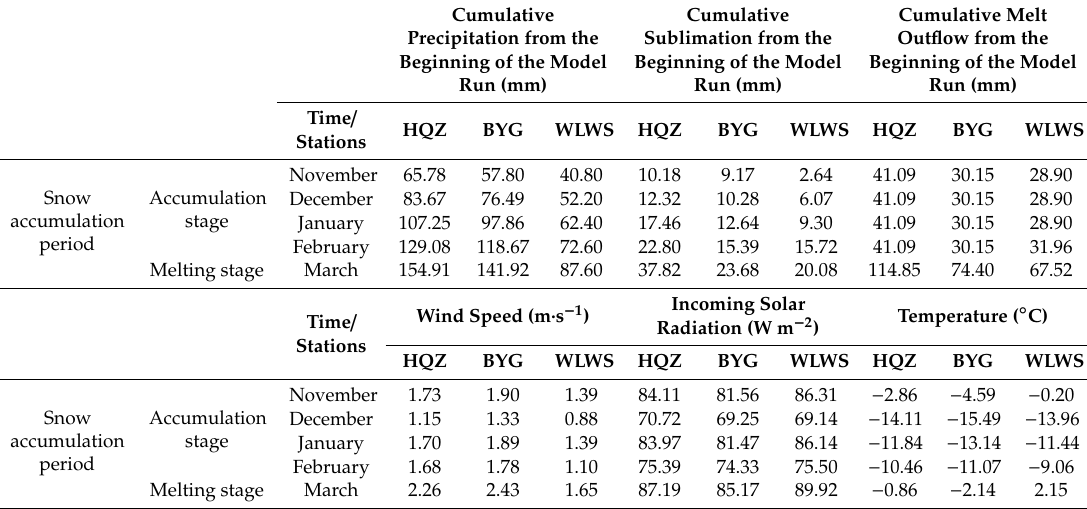
Figure 10. Trends in the simulated cumulative precipitation, evaporation, and melt outflow amount at 3-hour intervals between 0:00 on 1 November 2014 and 21:00 on 31 March 2015. Table 8. Different energy component contributions to snow mass loss.